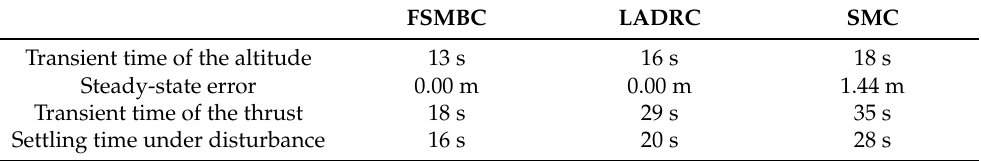
Figure 7. Thrust inputs for LADRC, SMC, and FSMBC. Table 2. The performance indexes of the control system.